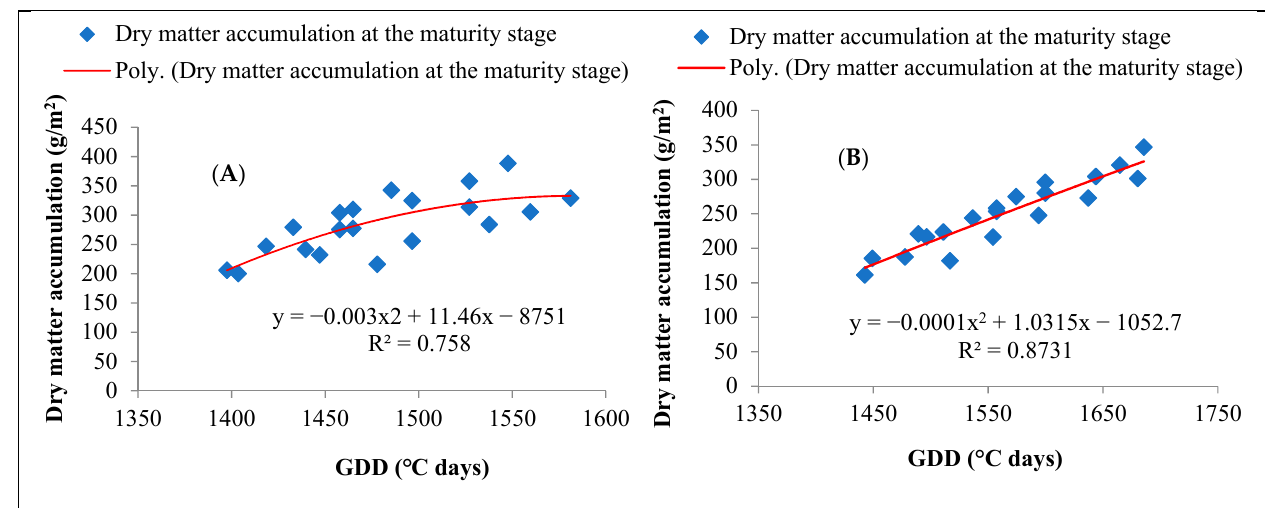
Figure 2. Impact of GDD on the final dry matter accumulation in black gram in ( A ) 2020 and ( B ) 2021. Accordingly, the seed yield of black gram was found to be a second-order polynomial function of HTU in both 2020 and 2021. An increment in HTU up to 12,000 day °C hours gradually escalated the seed yield, and thereafter a marginal improvement was observed in the first year and the second year (Figure 3A,B). However, the rise in HTU up to 13,000 day °C hours progressively increased the seed yield of the black gram sown in 2021. Variations in HTU could contribute to about 72.9% and 84.8% variation in seed yield of black gram irrespective of sowing dates in 2020 and 2021 (Figure 3A,B), respectively.